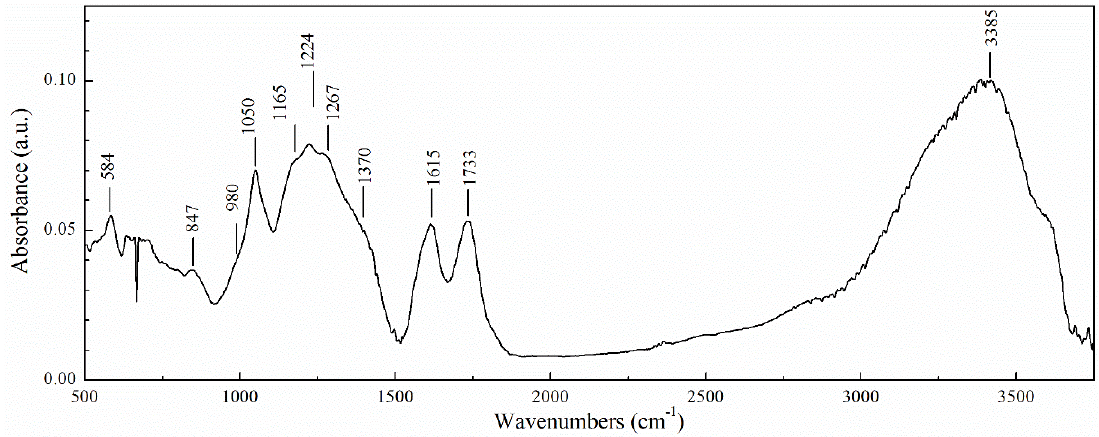
Figure 2. Fourier transform infrared (FTIR) spectra of GO.